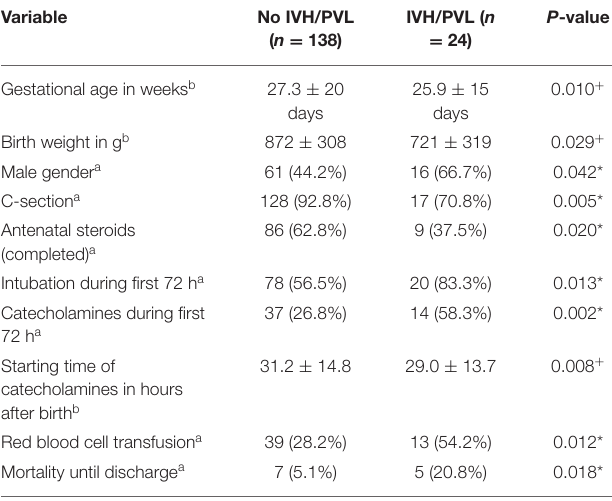
TABLE 1 | Demographic characteristics and clinical data in outcome groups.